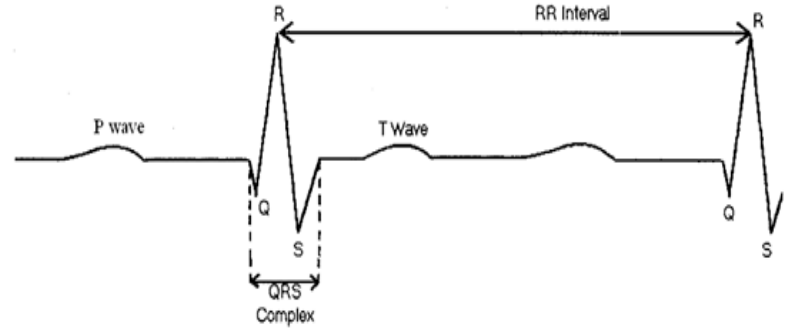
Figure 1. The components of an electrocardiogram (ECG) signal.